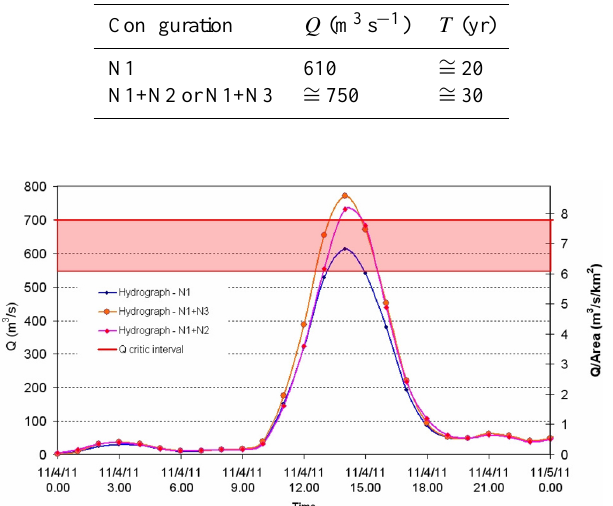
Table 2. Return period of the peak flows simulated for Bisagno creek using the three different input configurations.